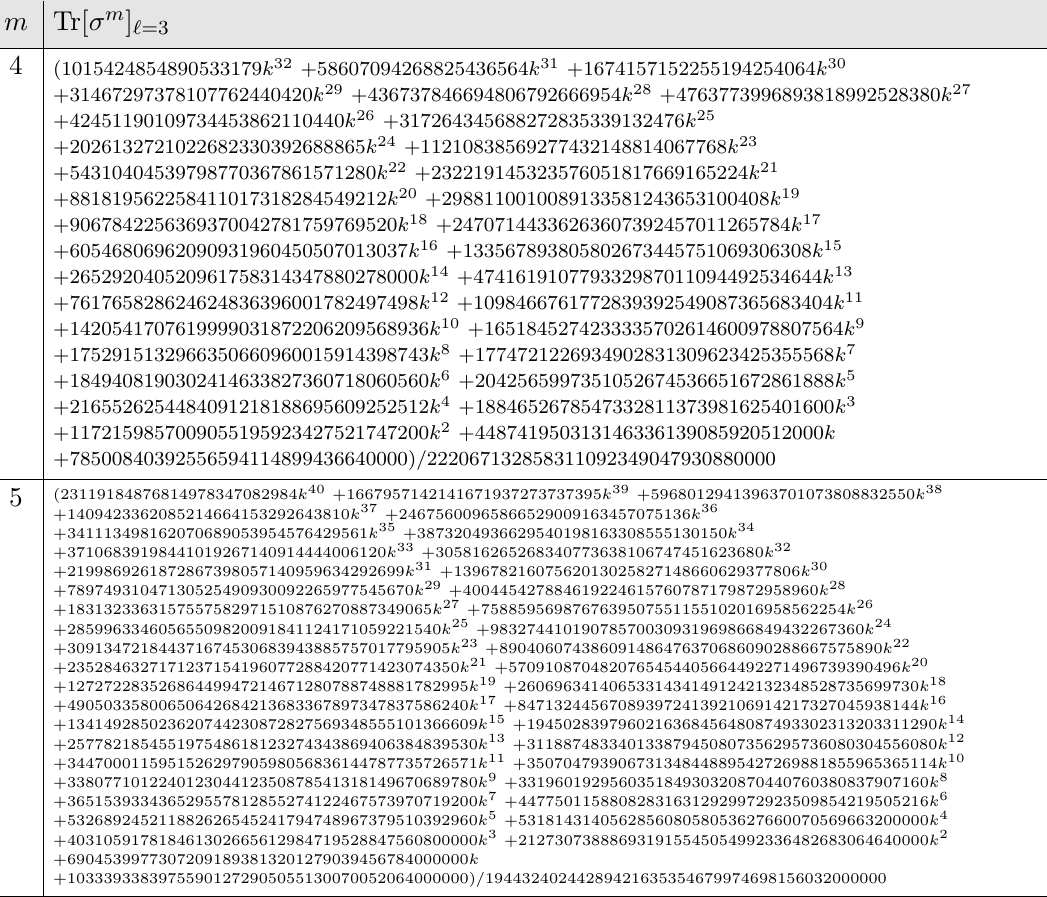
Table 11. The values of Tr [ σ m ] as a function of k for T 4 , 16 torus link. The subscript ‘ indicates that the formula is valid for k ≡ ‘ ( mod 4)